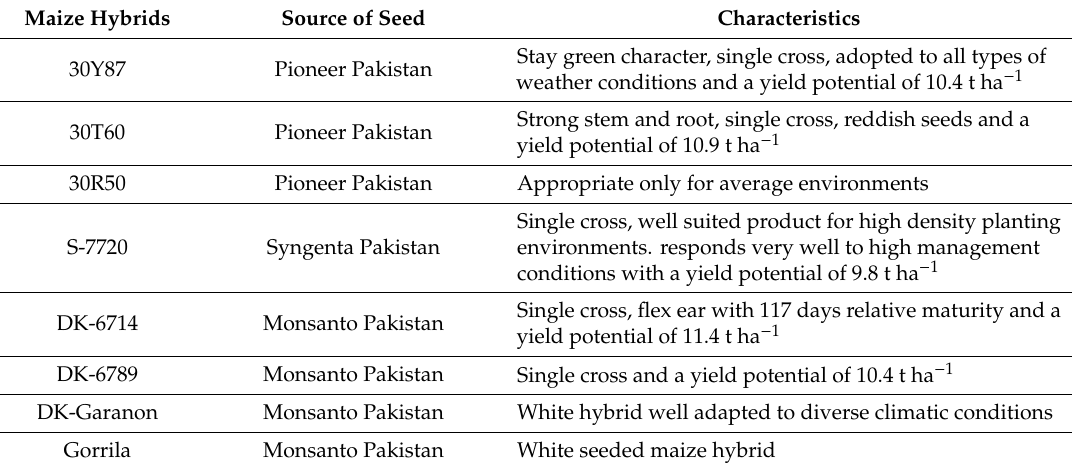
Table 2. Characteristics of maize hybrids used in the study. Maize